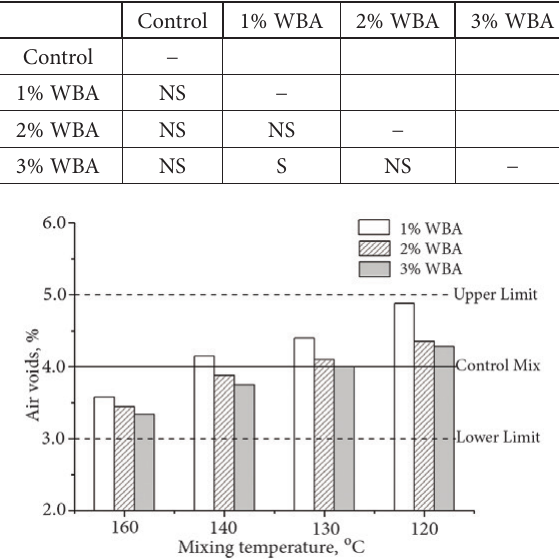
Figure 9. Air voids of WMA